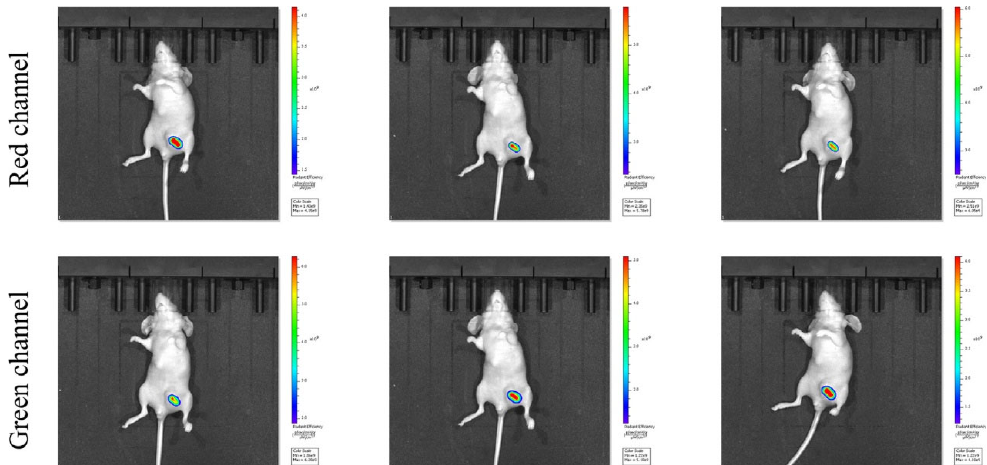
Figure 3. In vivo fluorescence imaging of probe 28 (10 µ M) with Na 2 SO 3 (100 µ M) in HepG2 tumor- bearing nude mice at 0, 5, and 15 min. Reproduced with permission from Ref. [59]. Copyright (2021) Elsevier.